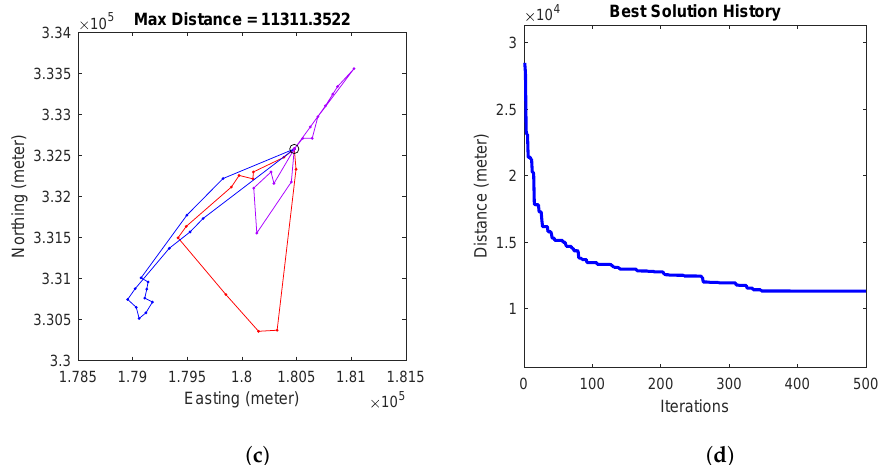
Figure 6. Generating robot paths for m = 3 robots. ( a ) Sensing locations to be visited by the robots; ( b ) Distance matrix between any two sensing locations where a location is represented by its index. ( c ) Paths traveled by the m = 3 robots when the total distance is minimized. We differentiate the paths of the m = 3 robots using three different colors. ( d ) Total distance history over path planning iterations.